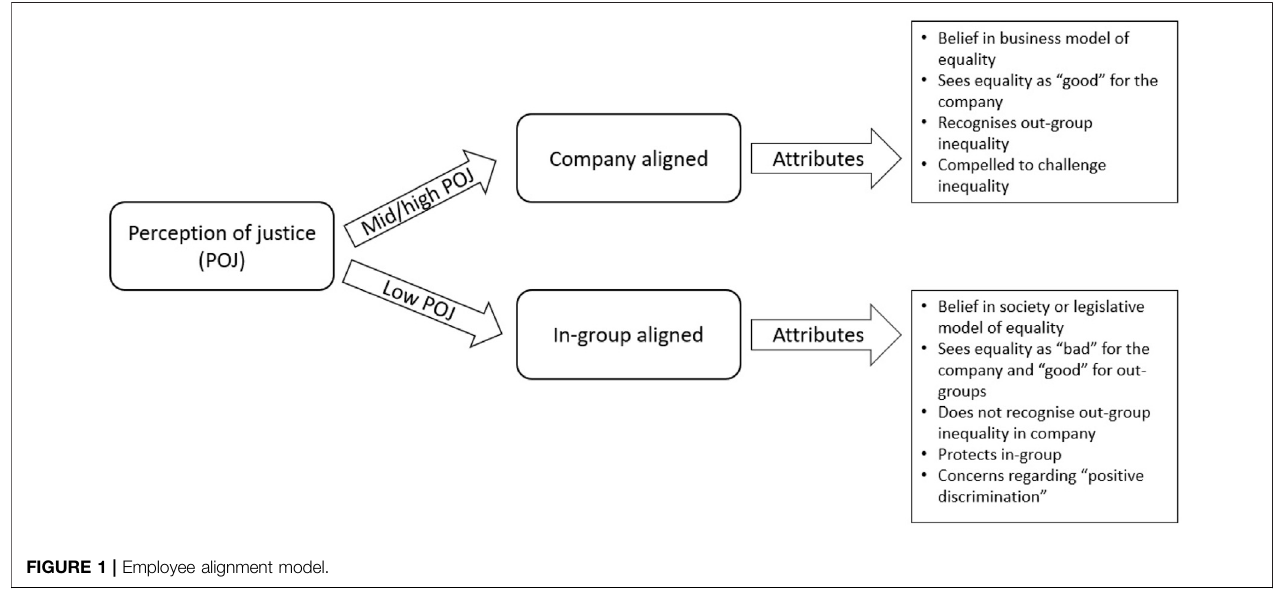
FIGURE 1 | Employee alignment model.